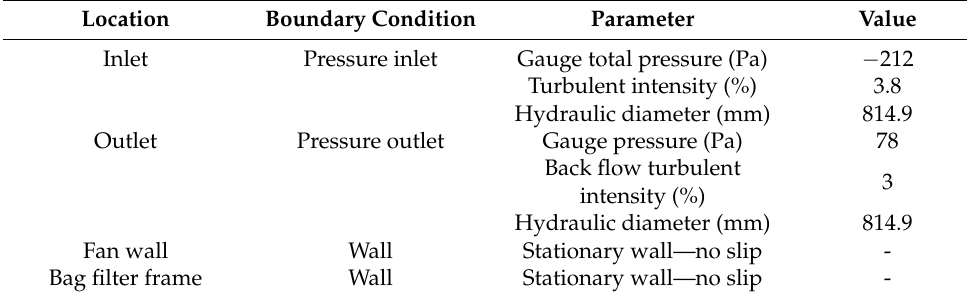
Table 4. Boundary conditions defined in the numerical model.